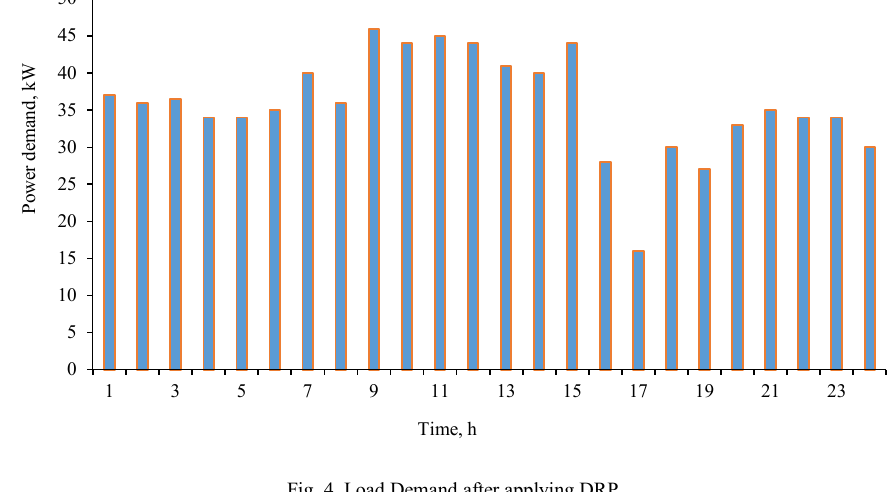
Fig. 4. Load Demand after applying